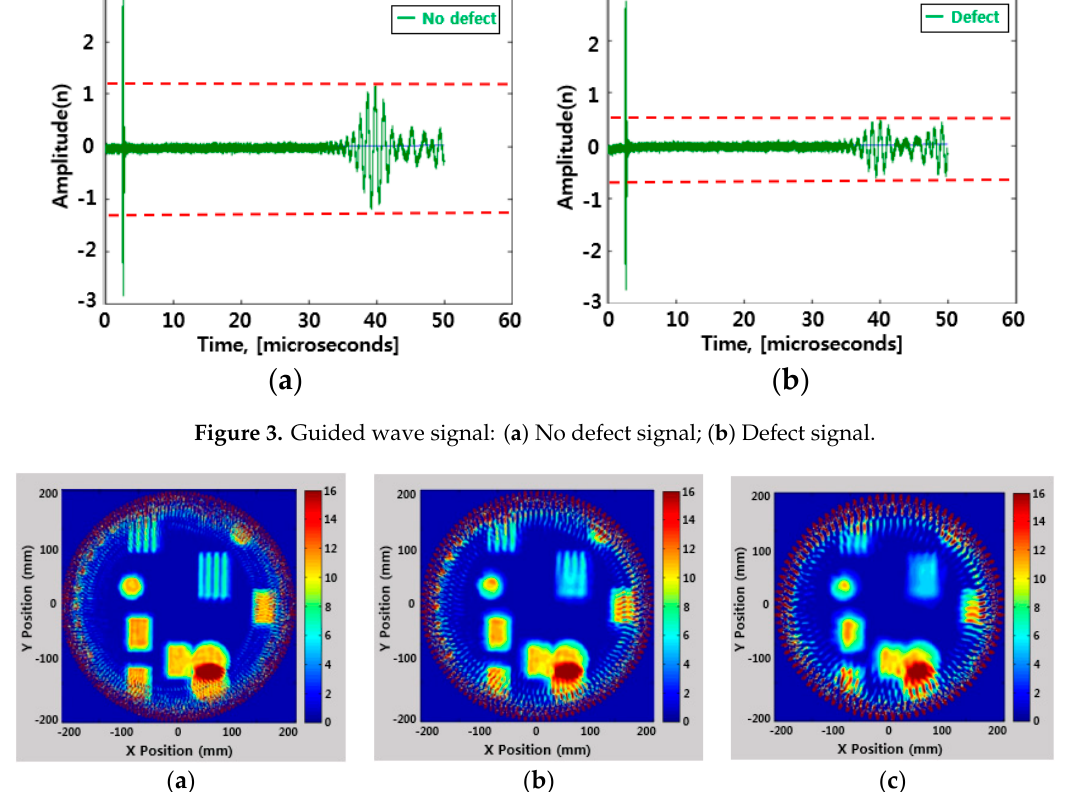
Figure 4. Simulated results from the filtered back projection (FBP) algorithm: ( a ) 180 Points; ( b ) 120 Points; ( c ) 90 Points.